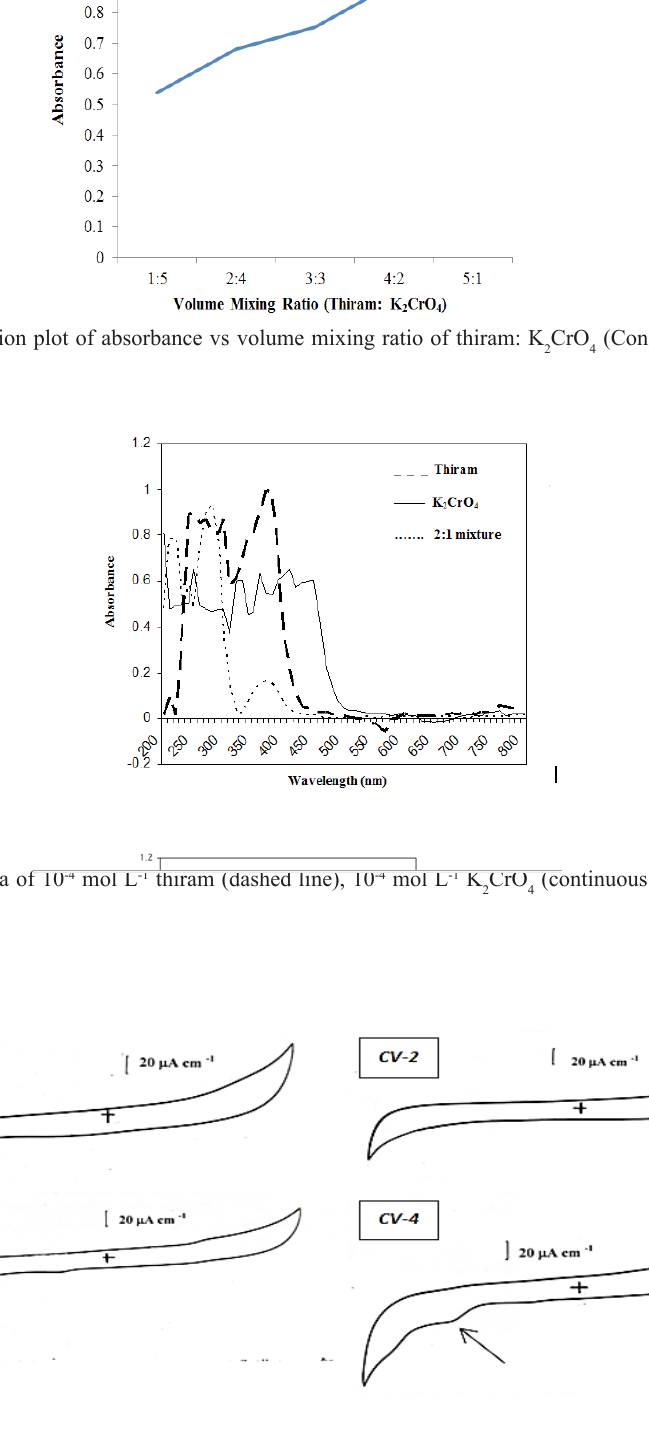
CrO ( CV-1 ), Ethanol: NaCl=3:2 system ( CV-2 ), 10 -4 mol L -1 of thiram 2 4